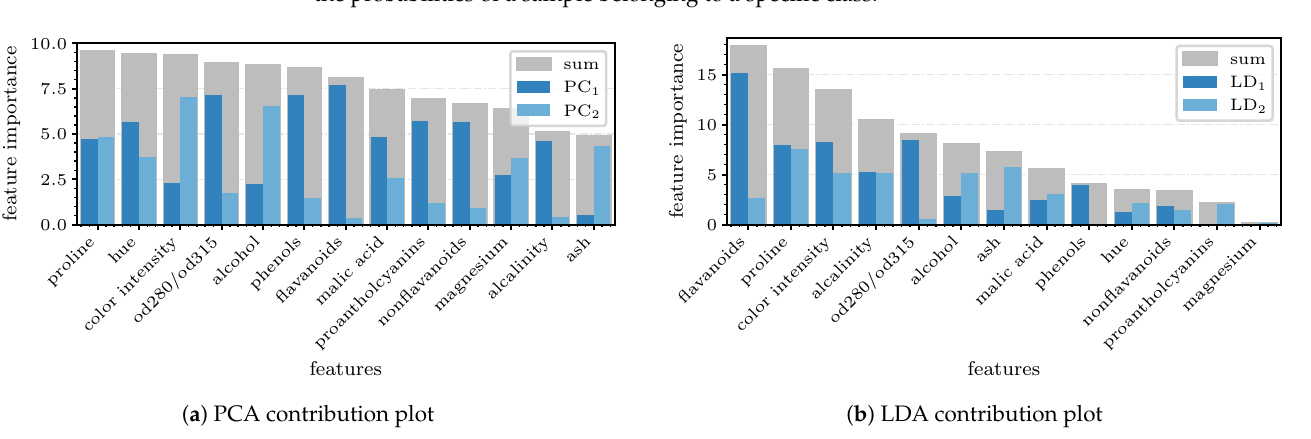
Figure 7. PCA ( a ) and LDA ( b ) score plots for the first two components of the Wine Classification dataset. The dashed ellipses are 3 σ confidence intervals around the classes’ scattering centers and are projected onto each axis at the right and top side of the plot. The colored background in ( b ) represents the probabilities of a sample belonging to a specific class.